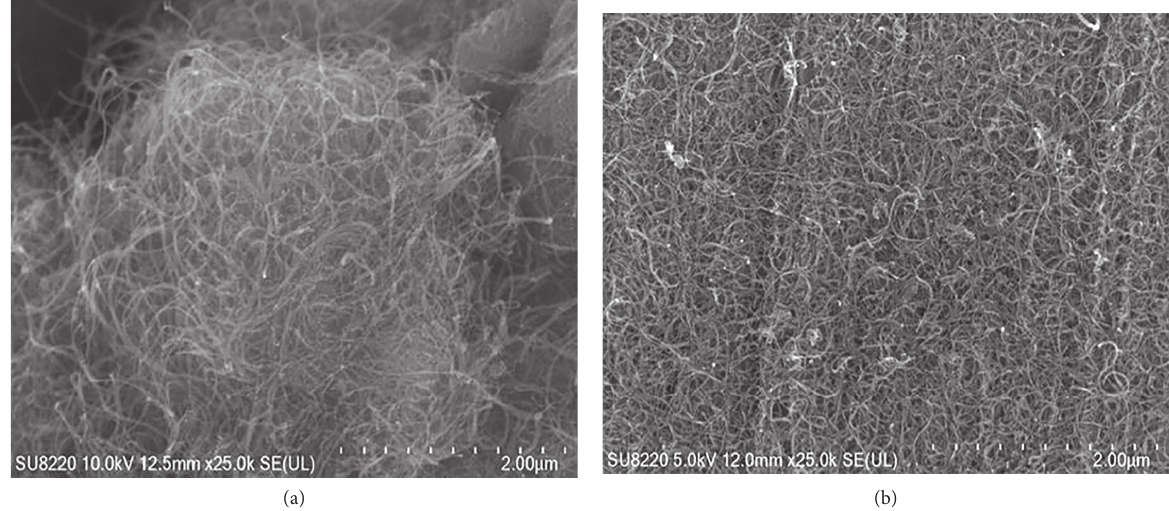
Figure 2: The SEM images of CNT-COOH (a) powder and (b) suspension after ultrasonic